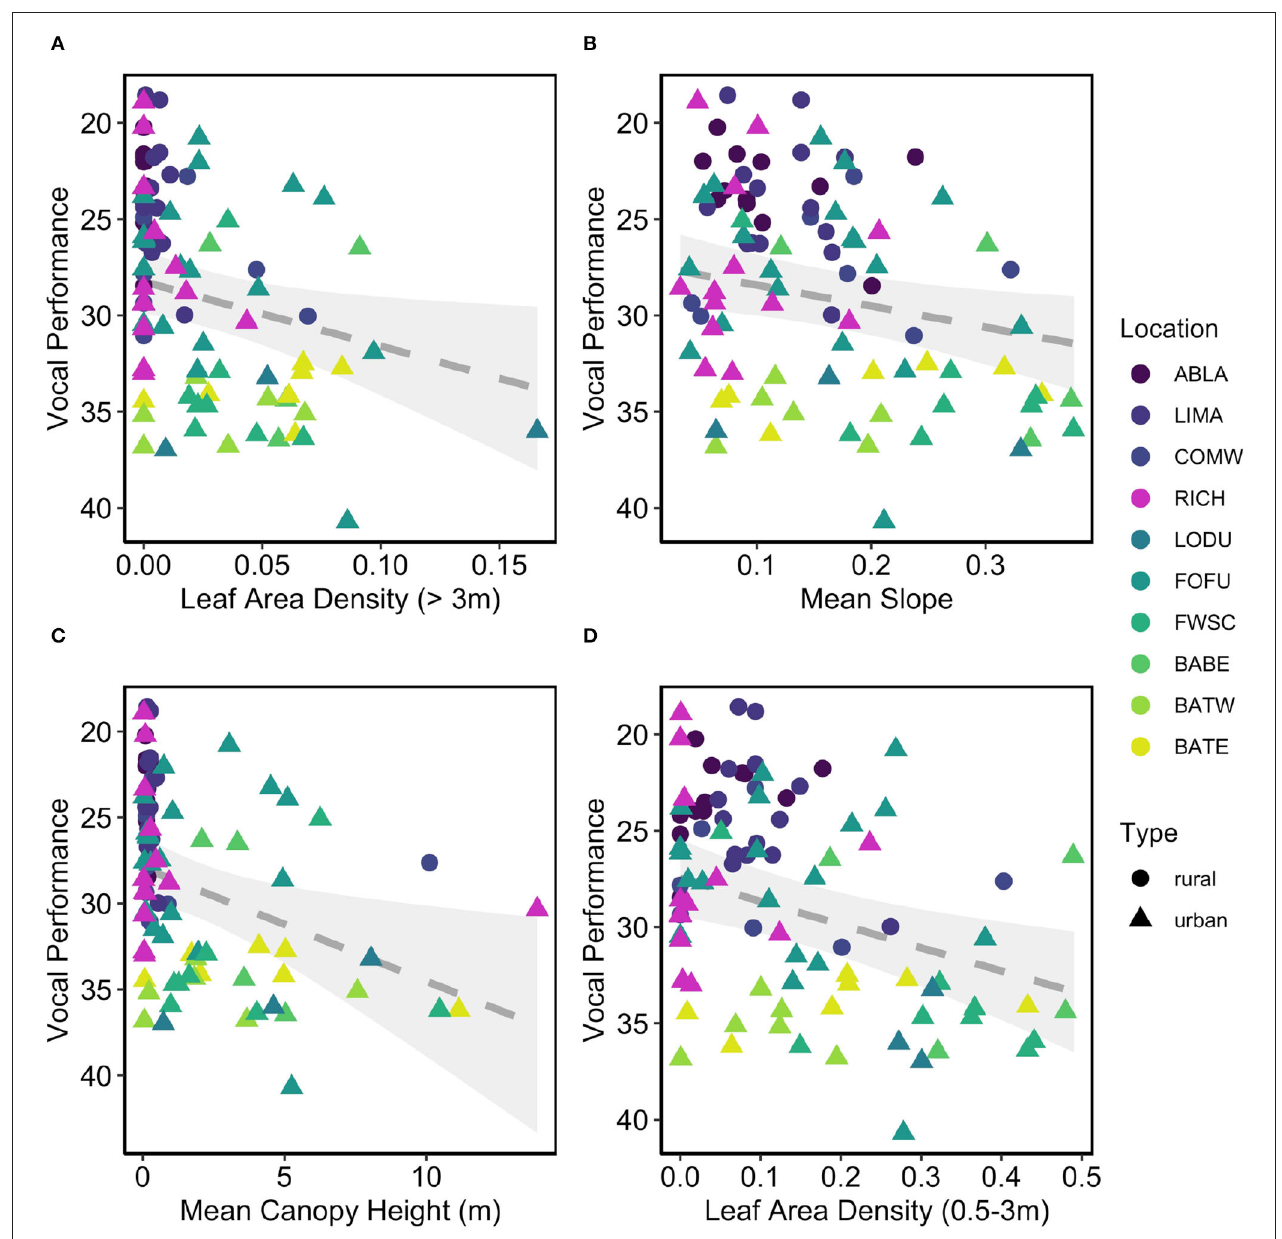
FIGURE 2 | Low performance males (high deviation) have territories with (A) denser canopies, (B) steeper slopes, (C) higher canopies, and (D) denser understories. Gray dotted line and band denotes line of best fit with standard error (A&B candidate model 1, C&D candidate model 6). (ER = 2,800, w i = 0.28, Location variance = 15.54, SD = 3.94, Table 2A ), and Scaled Mass Index ∗ Type (ER = 2,700, w i = 0.27, Location Variance = 7.48, SD = 2.74). The conditional model average supported strong effects of Type on vocal performance, rather than Fat or Scaled Mass Index ( Table 2B ). Our analyses with quantile regression performance values also supported the effect of Type over body condition measures ( Supplement 1 , Table S1 ). Rural birds had higher performance than urban birds (deviation mean ± SD. Urban: 30.54 ± 4.99, Rural: 24.56 ± 3.16).